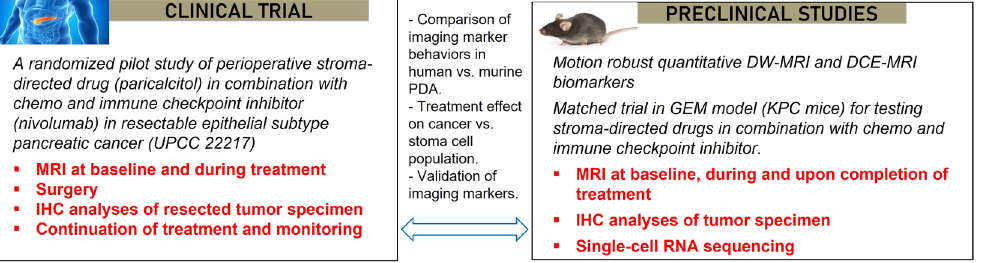
Figure 5. Co-clinical trial design for assessing MRI markers of tumor microenvironment changes in pancreatic cancer in response to a stroma-directed drug combined with chemo and immune checkpoint inhibitor.